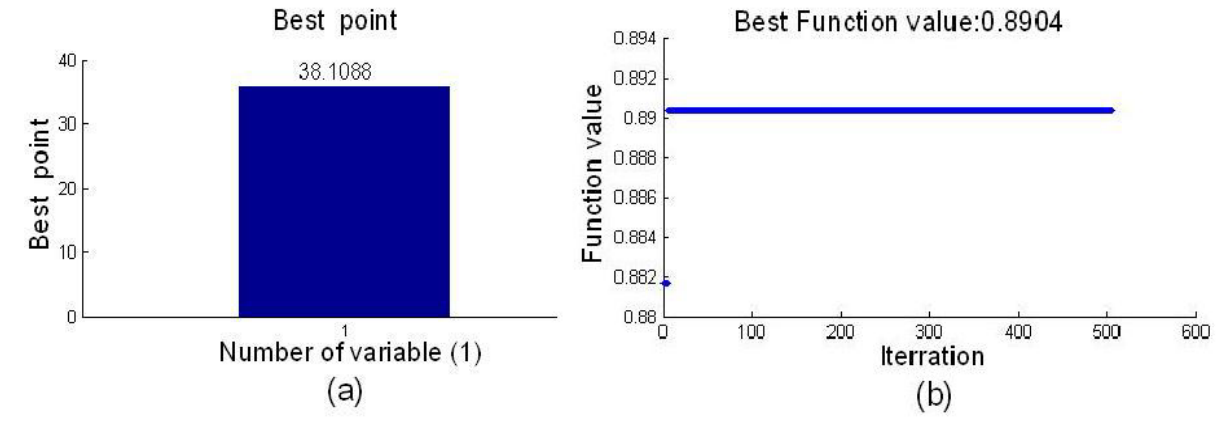
Figure 6. Result of optimal cutoff by SA. ( a ) Optimal cutoff. ( b ) Best function